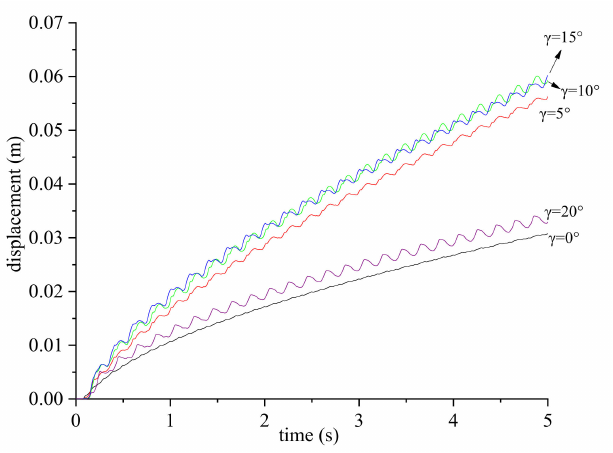
Figure 15. Displacement history of point D5 in the Y -direction for slopes subjected to the action of a sinusoidal wave. Each slope has α = 40 ◦ and β = 70 ◦ but different values of γ